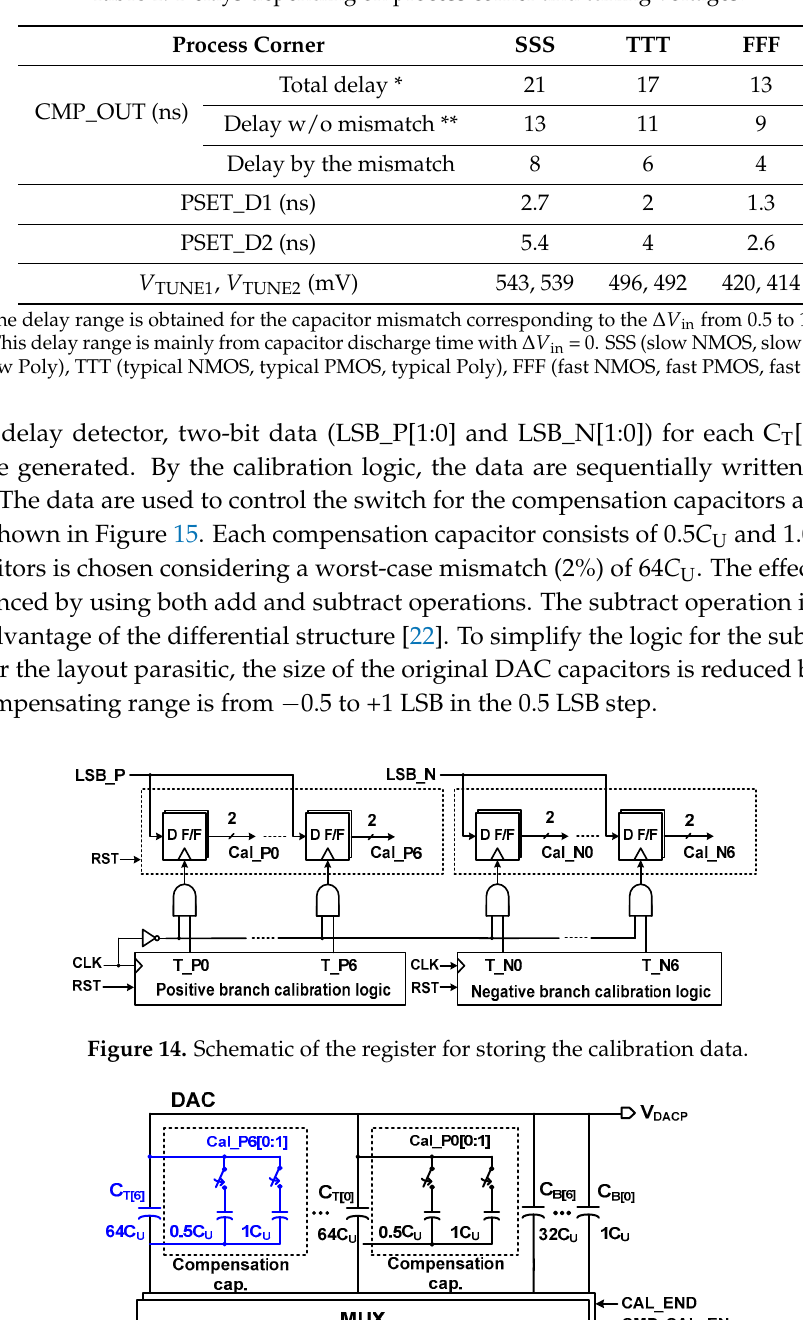
Table 1. Delays depending on process corner and tuning voltages.